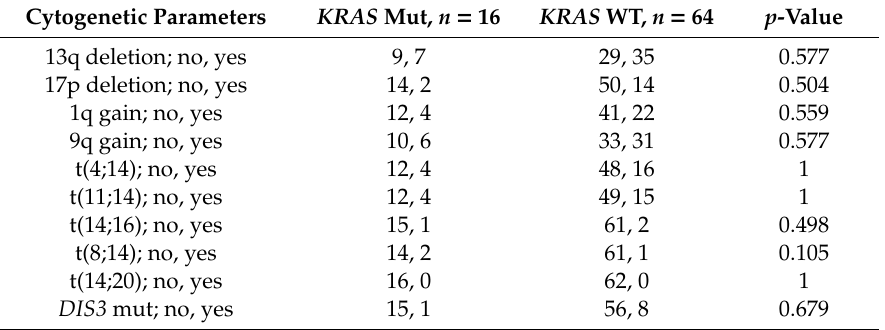
Table 1. Correlation of the KRAS mutation-status with classic cytogenetic parameters. mut: mutation, WT: wild type.